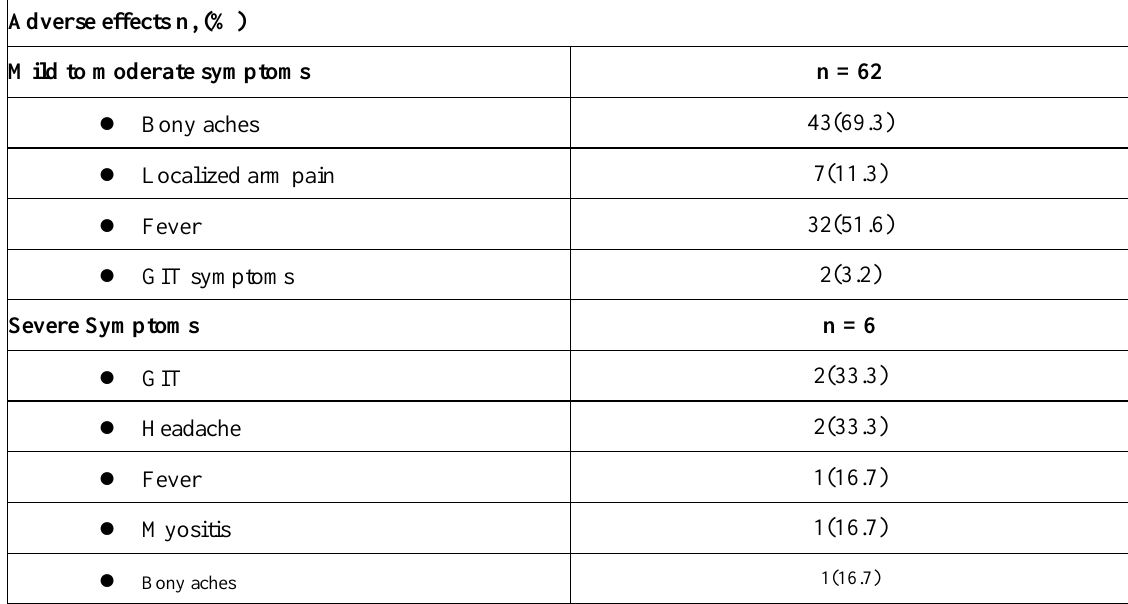
Table 2. Adverse effects of the vaccinated